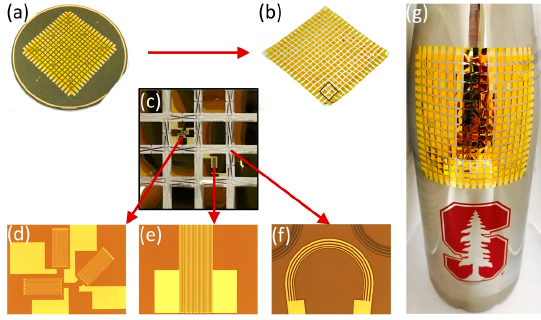
Figure 7. ( a , b ) Network appearance before and after release from the supporting wafer; ( c – f ) Network details from macro to micro scale; ( g ) A flexible network wrapping an irregularly shaped water bottle.